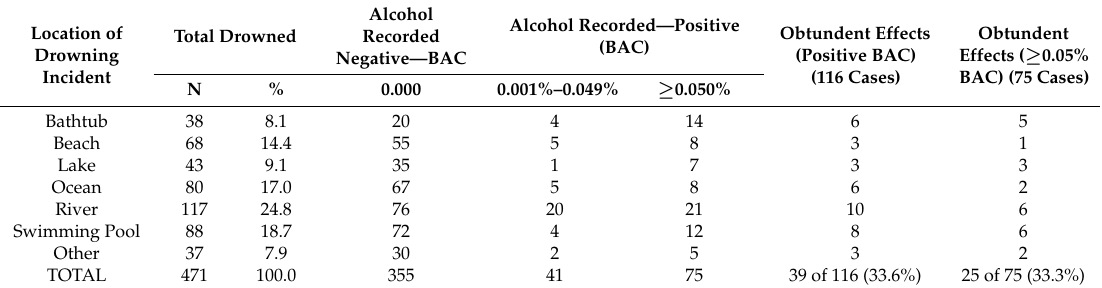
Table 2. Closed coronial cases by involvement of alcohol and presence of obtundent drugs among drowning fatalities in Australia, by location of drowning incident, 2002/03 to 2016/17 with toxicological information available, in victims aged 65 years and over (N = 471). Location of Drowning